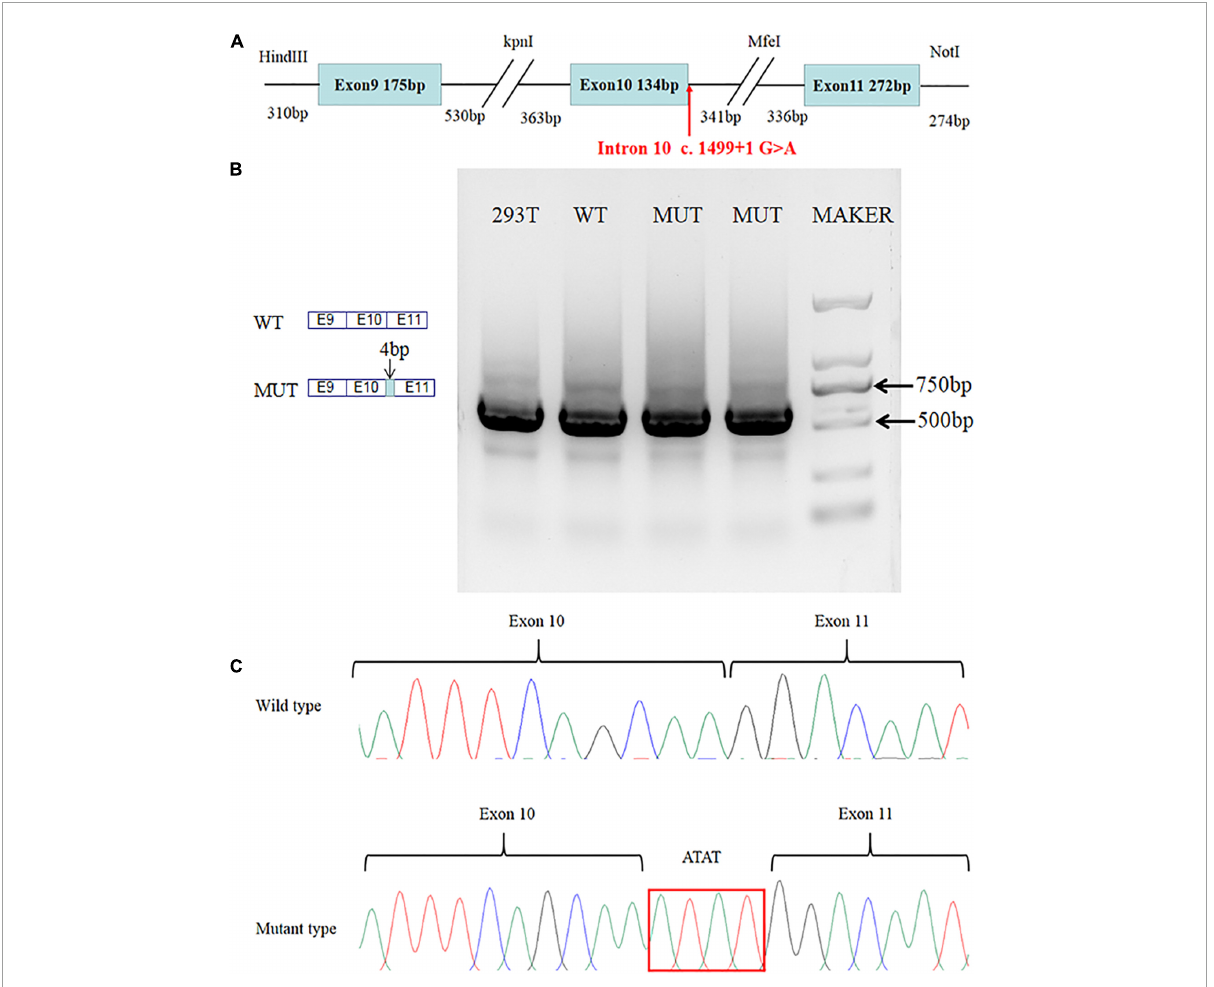
FIGURE2 Results of the minigene assay. (A) SLC4A4 minigene structure: schematic diagram of the SLC4A4 minigene construct containing exon 9, part of intron 9, exon 10, part of intron 10, exon 11, and part of intron 11. (B) Agarose gel electrophoresis showed a single band in the WT and one band from the MUT. Moreover, the DNA fragments represented by the two strips might be similar in length. (C) The mutant type causes a 4-base insertion between exons 10 and 11 of SLC4A4 after expression in HEK293 cells.